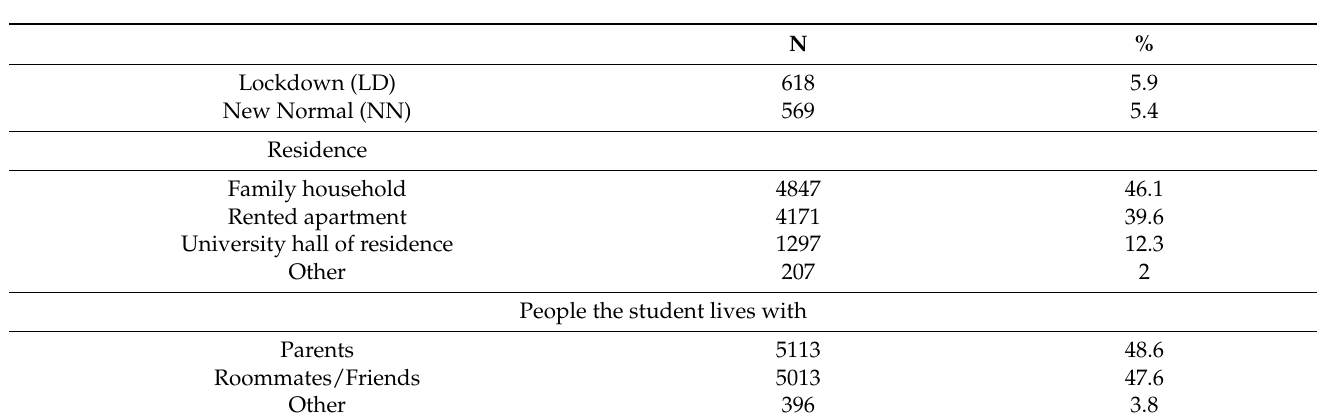
Figure 2. Evolution of the prevalence of cannabis use (%) in university students, past 12 months and past 30 days, by sex. Error bars show a 95% confidence interval on the prevalence rates. * p < 0.05 Male vs. Female (past 12 months); # p < 0.05 Male vs. Female (past 30 days). 3.2. Changes in the Pattern of Use during the First Lockdown and during the COVID-19 Pan- demic Concerning the first lockdown (May-June 2020), 18.8% (95% CI 13.1–26.0), of canna- bis users reported maintaining their use while 35.4% (95% CI 27.9–43.6) increased it and 45.8% (95%CI 37.7–54.1) decreased it. Regarding the pattern of use during the COVID-19 pandemic, Figure 3 shows the changes in the pattern of use during the pandemic, as well as the proportion of users who reported using cannabis as a coping strategy. According to our results, 20.3% (95%CI 15.4–26.3) of students reported a decrease in cannabis use during the pandemic, while 32.5% (95%CI 26.5–39.2) reported no changes in their use, and a large percentage of users, 47.2% (95%CI 40.5–53.8), increased it. About coping use, there